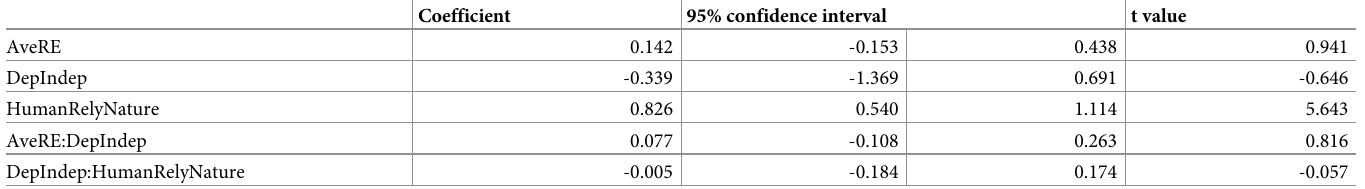
Table 3. Output of ordinal regression Model 2. AveRE: the average scores for all the RV statements. DepIndep: the respondent’s assigned grouping. HumanRelyNature: the scores for the statement that humans are fully dependent on nature in real life.